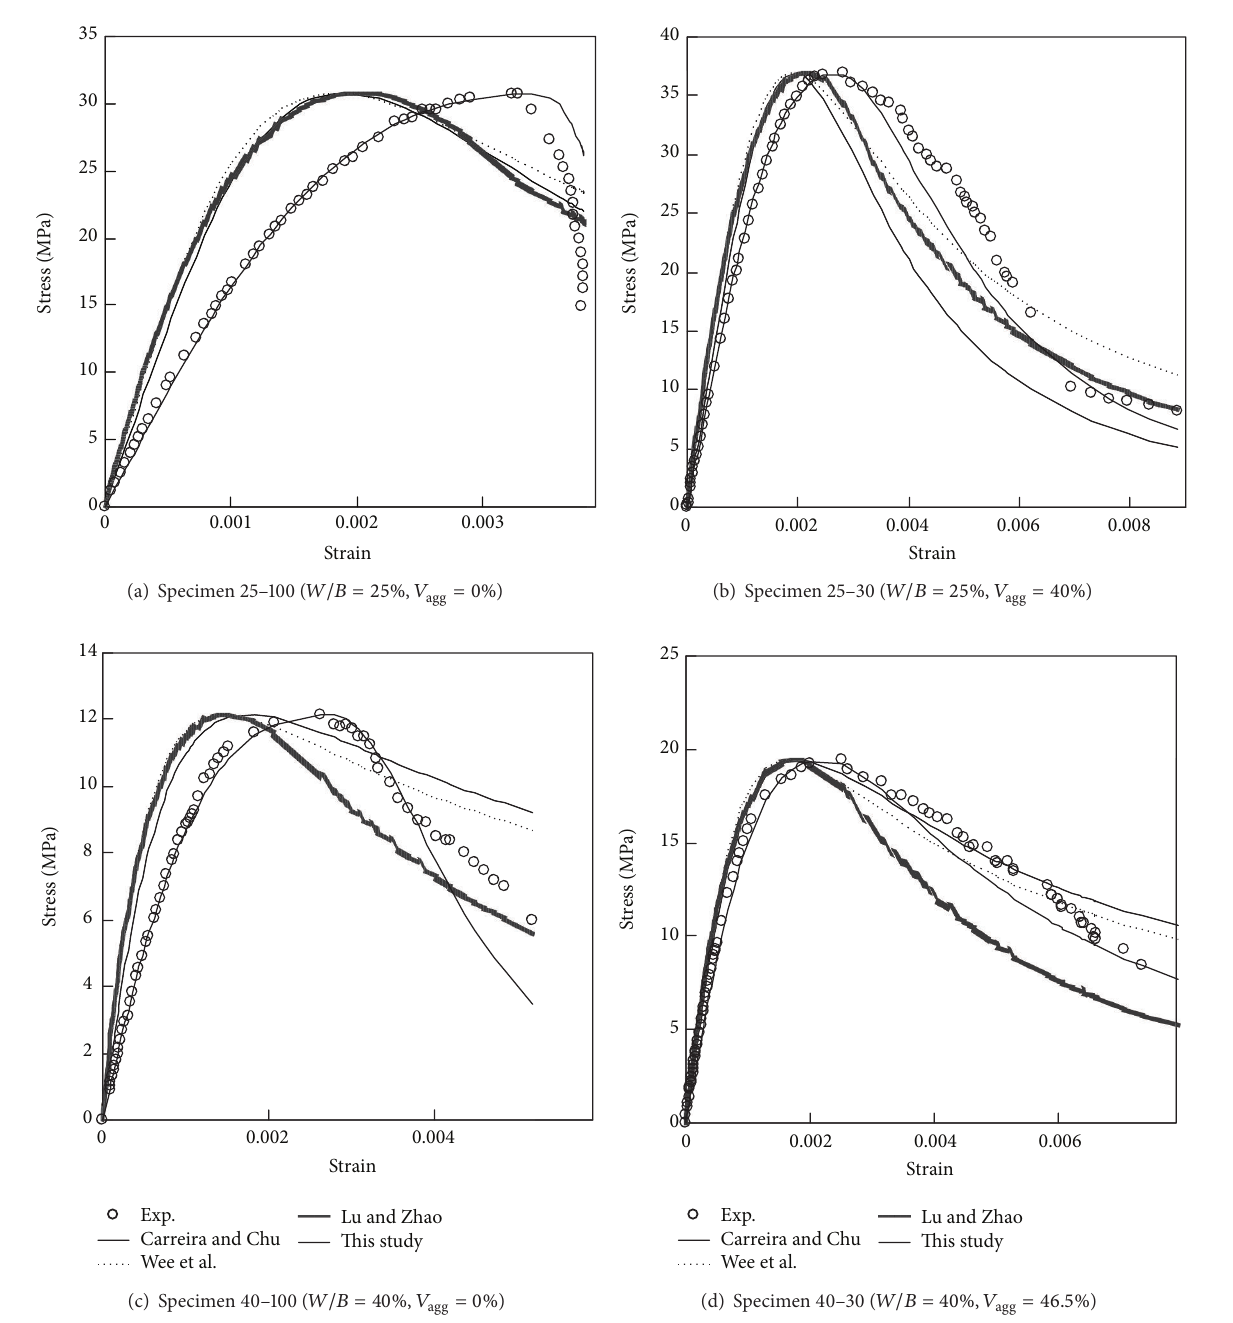
Figure 10: Typical comparisons of predicted and measured stress-strain curves for various 𝑊/𝐵 ratio and 𝑉